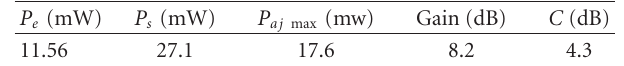
Table 2: Load pull simulation